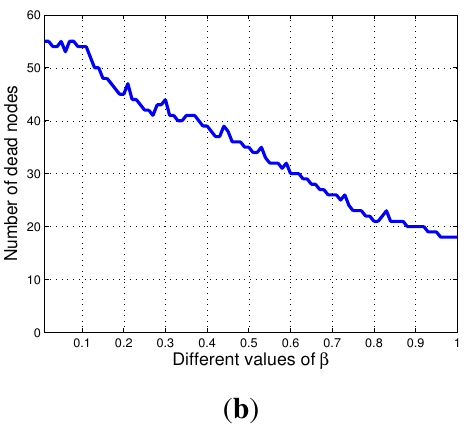
Figure 7. Impact of β . ( a ) The number of dead nodes of the AEDG for different values of β ; ( b ) the number of dead nodes of the AEDG for different values of β at a specific time